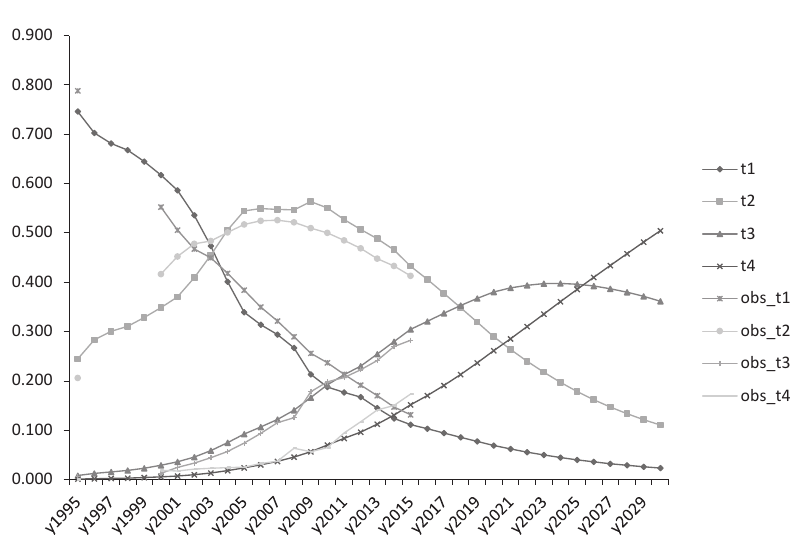
Fig. 2. Simulated development (2000–2029) and observed real development (2000–2015). Source: Official agricultural statistics (www.stat.luke.fi) on the distribution of dairy cows in